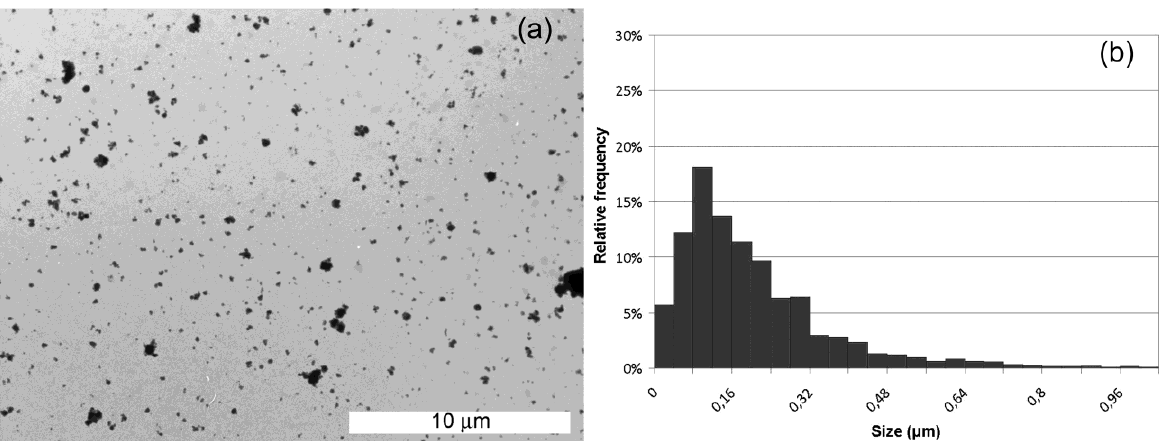
Figure 4. Transmission electron microscopy (TEM) images of crystalline samples milled 20 h ( a ) and particle distribution obtained ( b